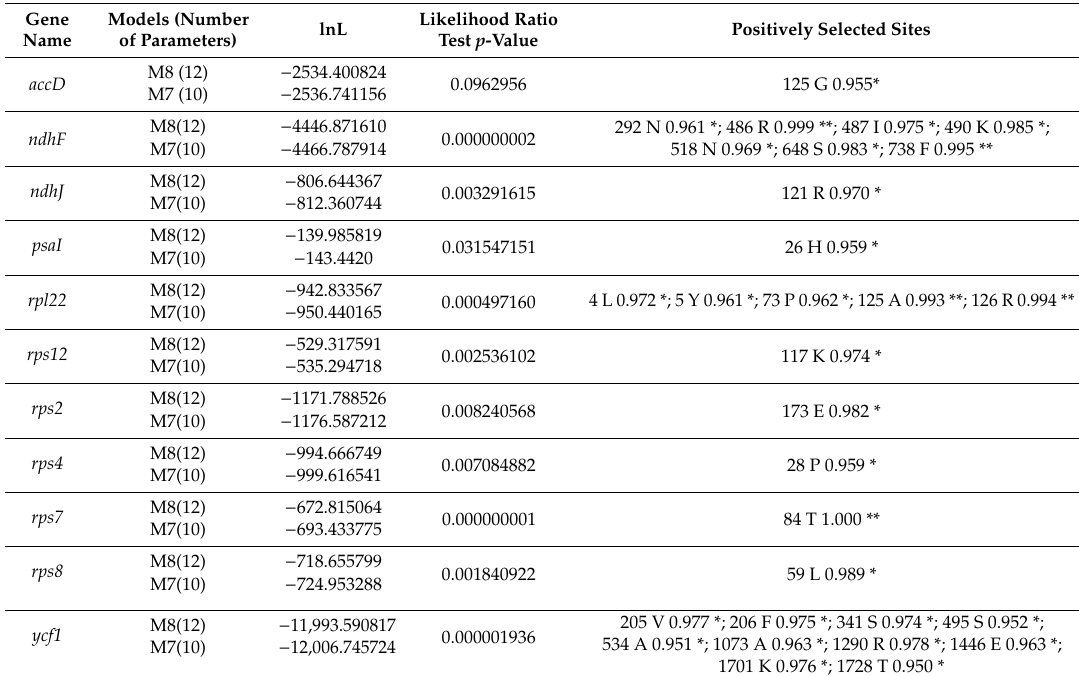
Table 5. Log-likelihood values of the site-specific models, with detected sites having non-synonymous / synonymous (dN / dS) values >